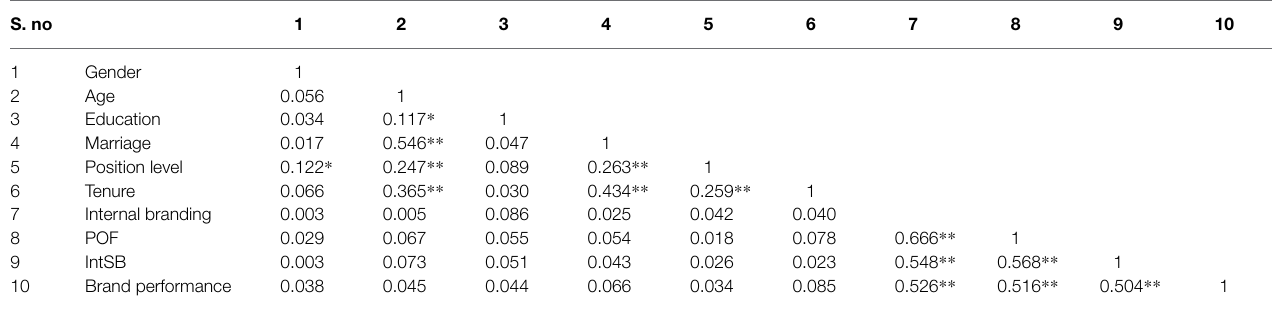
TABLE 3 | Descriptive statistics and